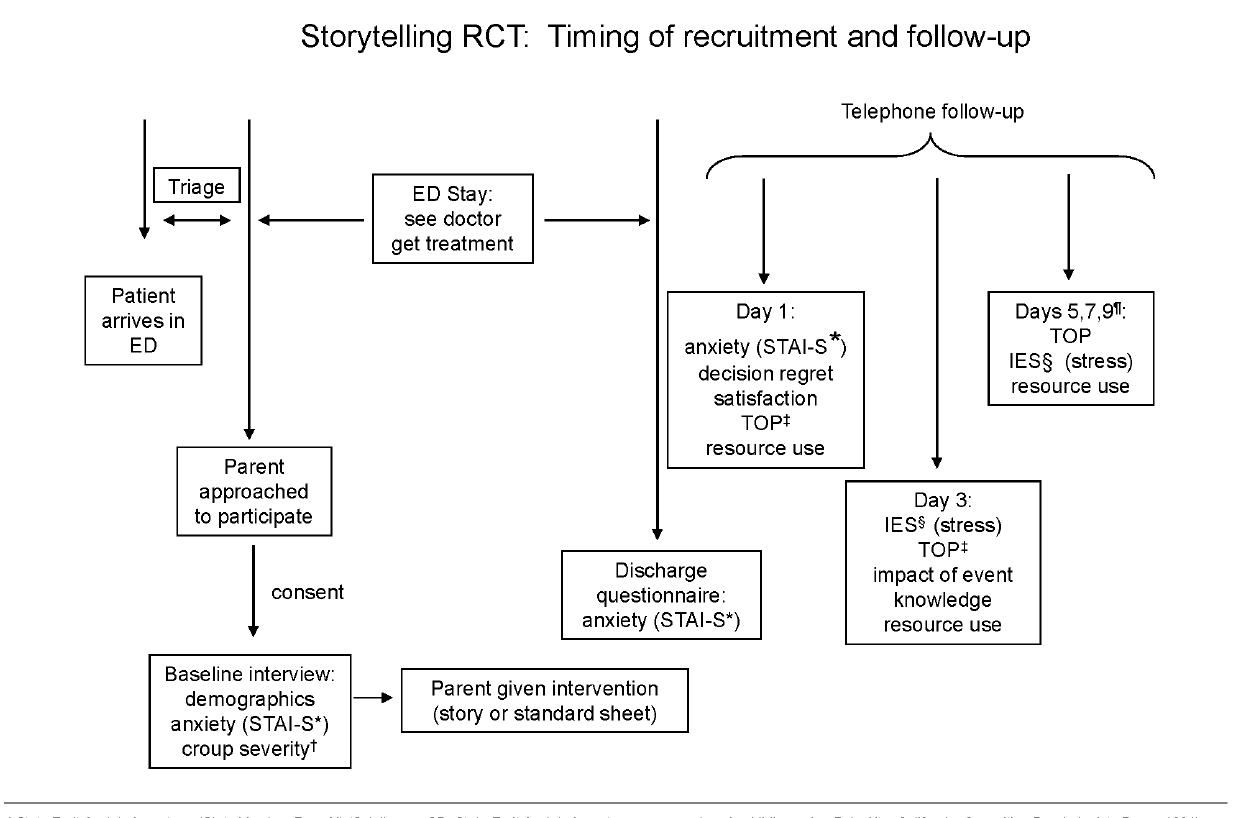
Figure 1. Flow diagram of patient recruitment and